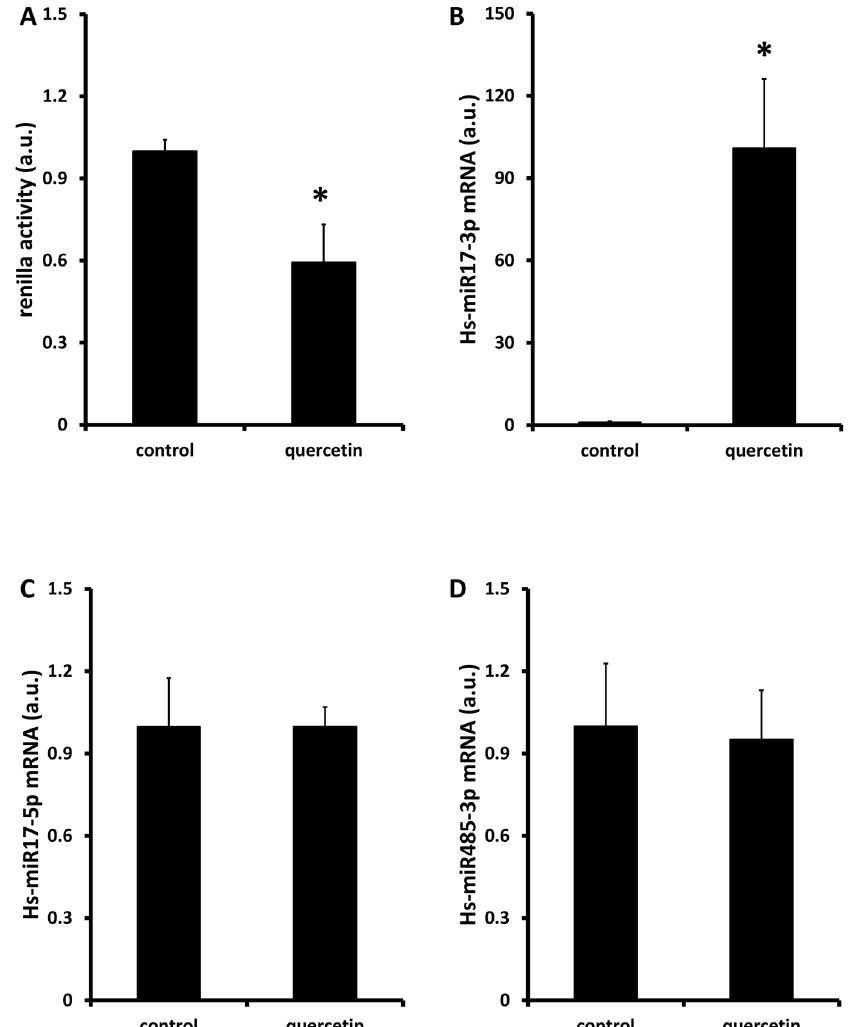
Figure 6. Effects of quercetin on the activity of FPN 3 9 UTR. (A) Caco-2 cells were transfected with MISSION FPN 3 9 -UTR-Renilla luciferase reporter construct and exposed to quercetin (10 m M) for 18 h. (B-D) Quantitative PCR was used to determine the effects of quercetin on the expression of candidate microRNAs predicted to interact with the FPN 3 9 UTR. Data are mean 6 SEM of 5-6 observations in each group. *P , 0.05 compared with control group (Student’s unpaired t-test).